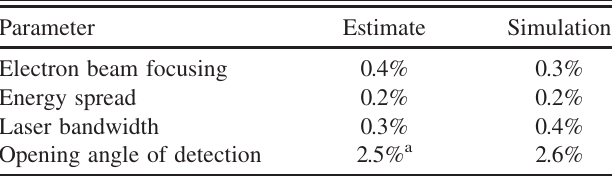
TABLE II. Comparison of contributions to x-ray spectrum bandwidth between analytical estimates and simulation, both as found in